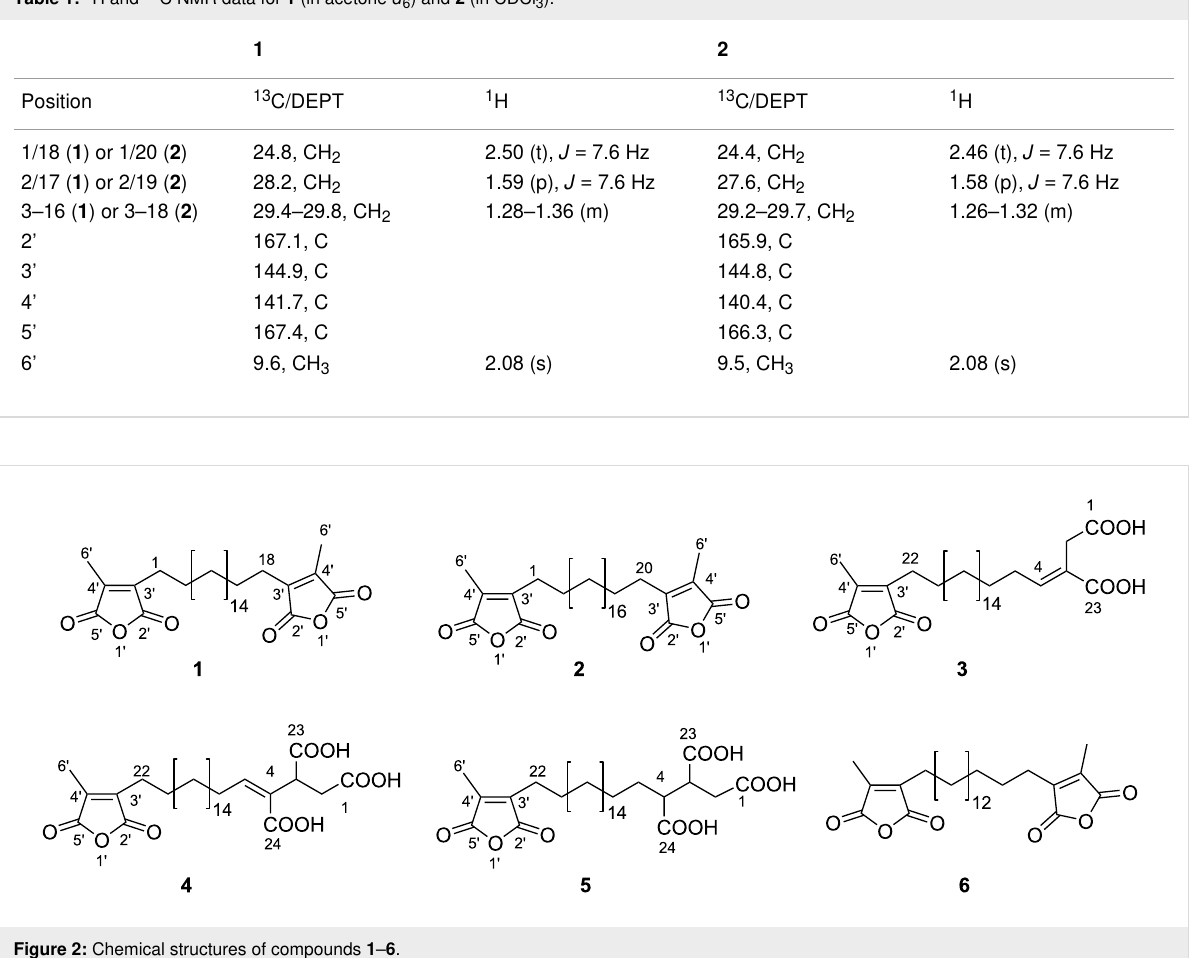
Table 1: 1 H and 13 C NMR data for 1 (in acetone- d 6 ) and 2 (in CDCl 3 ).